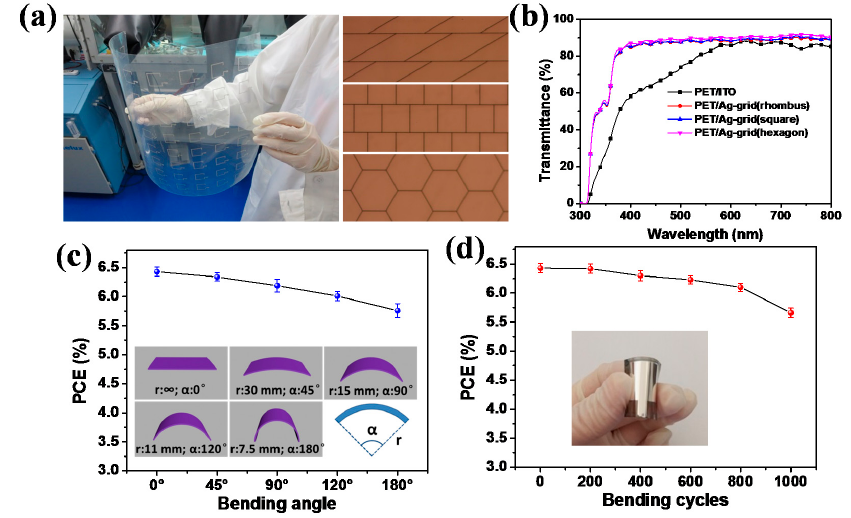
Figure 12. ( a ) Photograph of large-area PET/Ag-grid substrate ( left ), optical microscope images of three Ag-grid: rhombus, square and hexagon ( right ); ( b ) Transmittance spectra of PET/ITO and PET/Ag-grid (rhombus, square and hexagon) substrates; ( c ) PCEs measured while bending the flexible devices at different angles, the inset shows the schematic images of different bending angles (bending radii); and, ( d ) PCEs measured after bending the flexible device for different cycles with bending angle of 120°, inset shows the photograph of one flexible solar cell. Reprinted from [96], Copyright 2017, with permission from Elsevier.